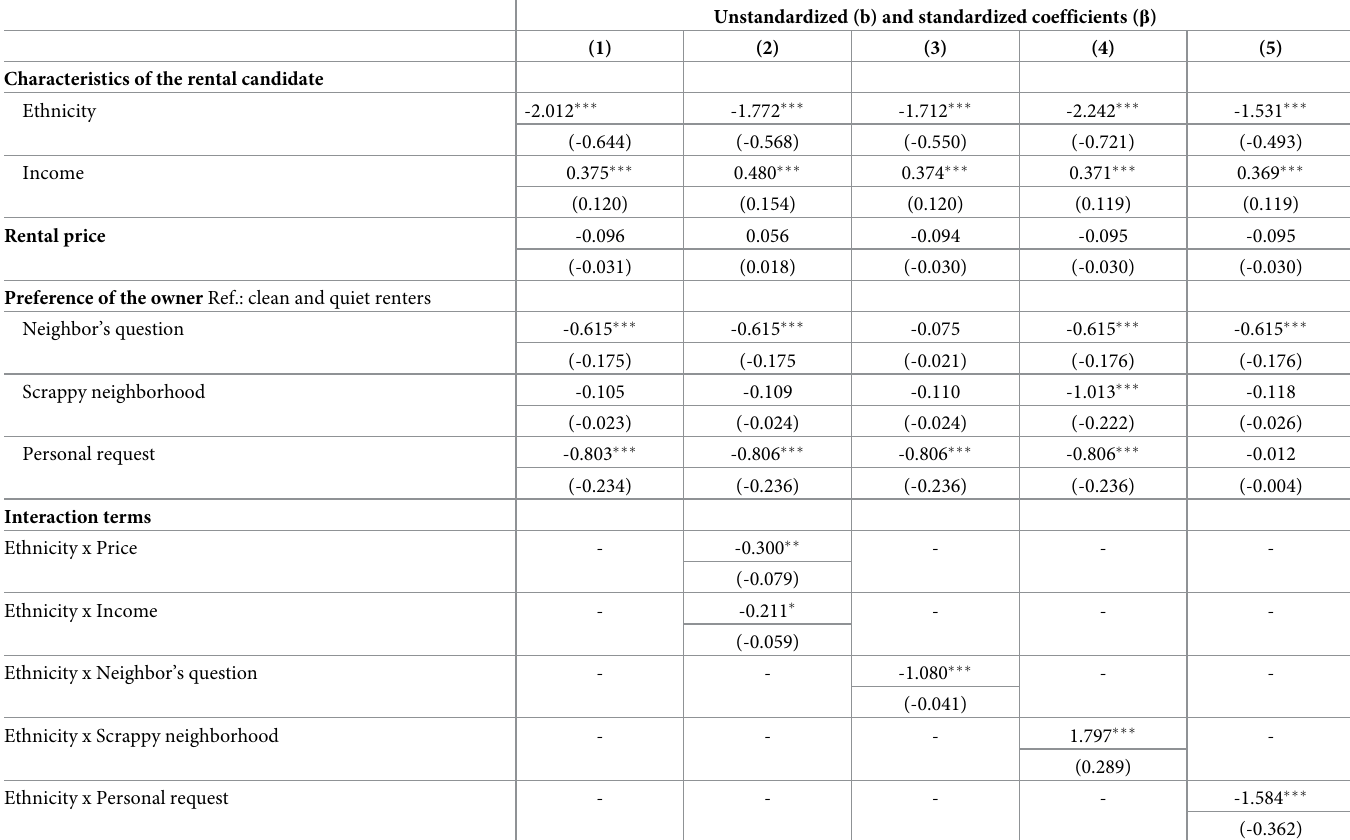
Table 4. Linear regression analyses of the owner taste-based